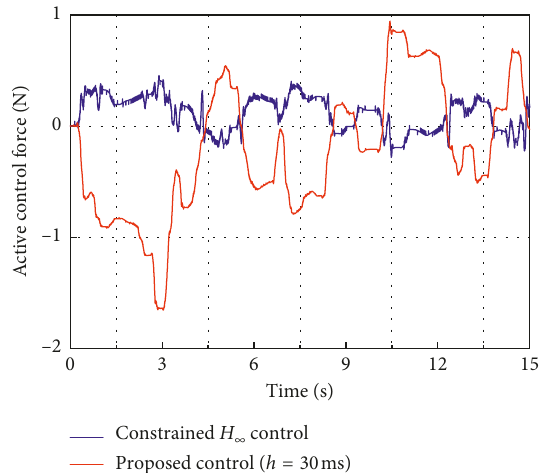
Figure 19: Hardware results of active control force under random road signal. Table 3: Indicators of suspension outputs in the hardware test. Hardware test outputs